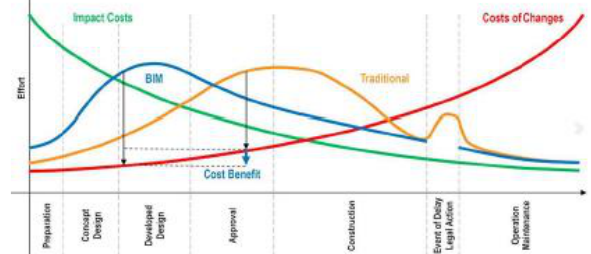
Figure 2. BIM vs Traditional CAD Planning - source_P. Mac Leany HOK and Dr T. Liebich, AEC3 Deutschland GmbH, 2013 2.2 Inclusive